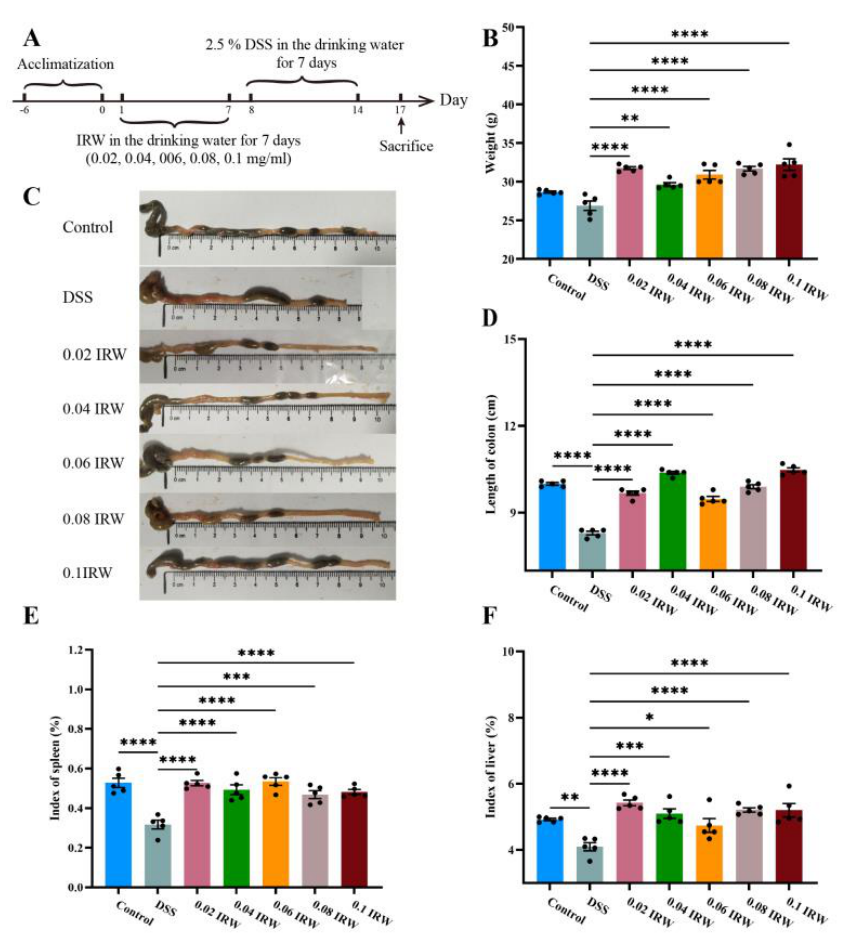
Figure 1. Effects of different concentrations of IRW on weight, colon length and visceral weight in mice: ( A ) experimental process, ( B ) mouse weights, ( C ) photos showing colon length, ( D ) colon length statistics, ( E ) index of spleen, and ( F ) index of liver ( n = 5); * indicates p < 0.05; ** indicates p < 0.01; *** indicates p < 0.001; **** indicates p < 0.0001.